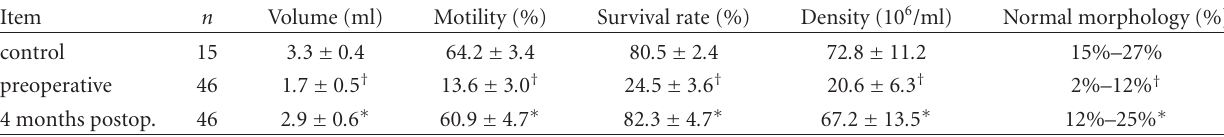
Table 3: Comparison of pre- and post-operative semen analyses between the study and control